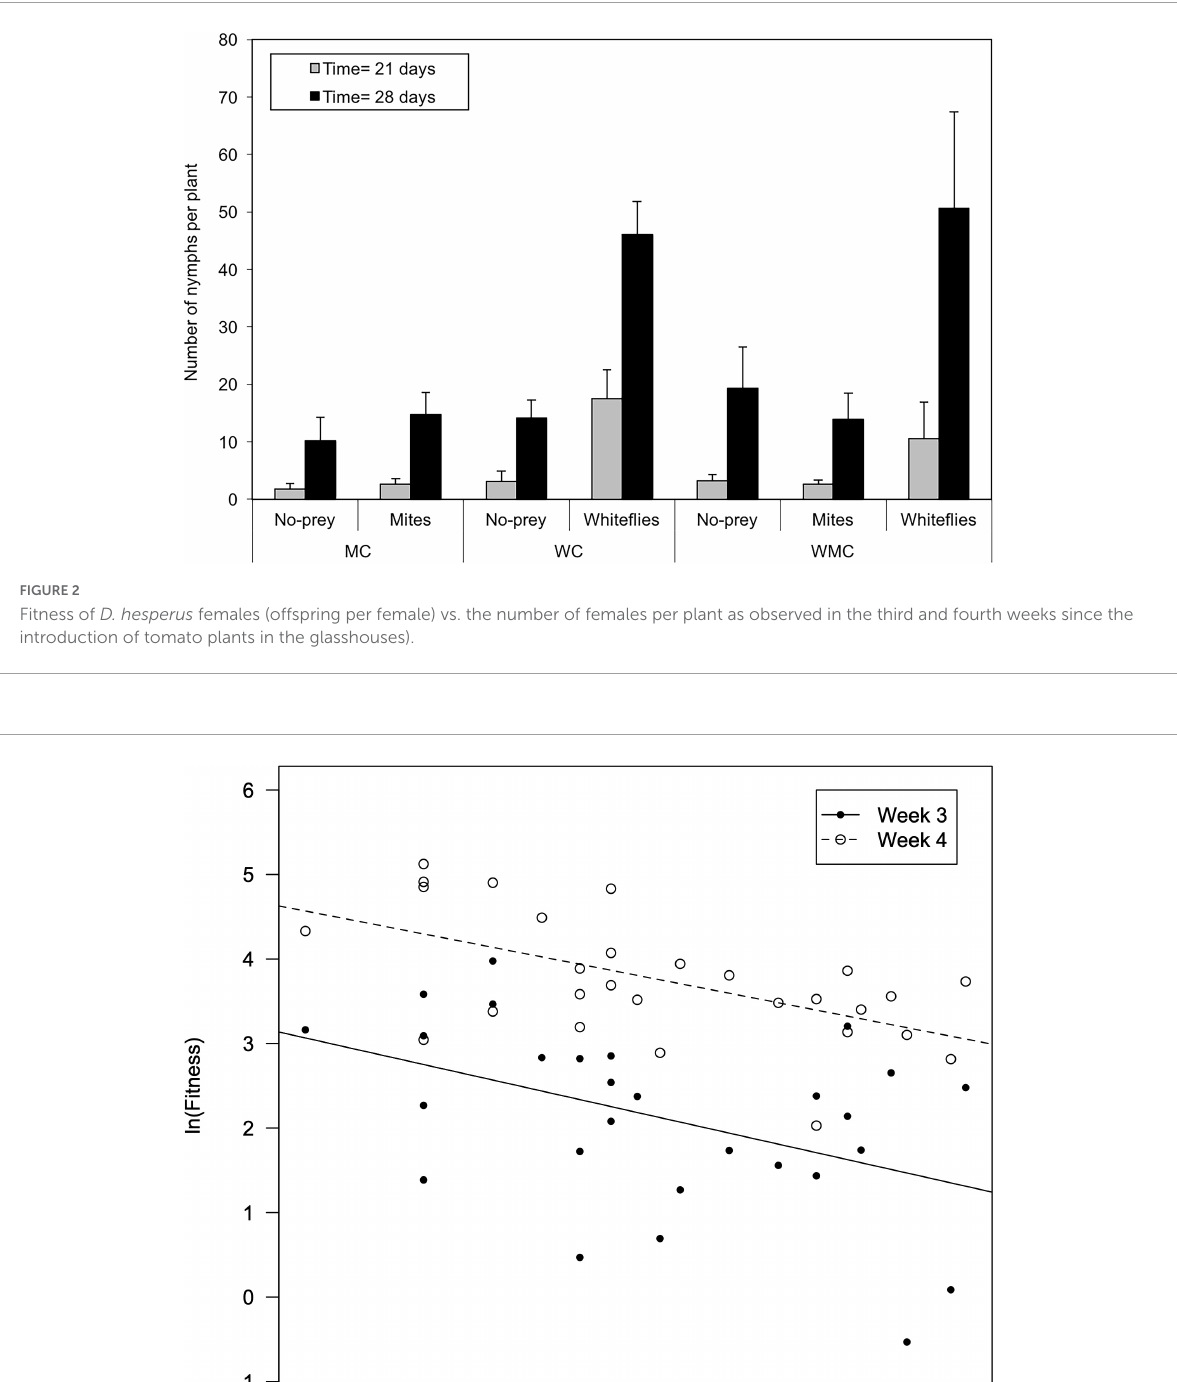
Frontiers in Ecology and